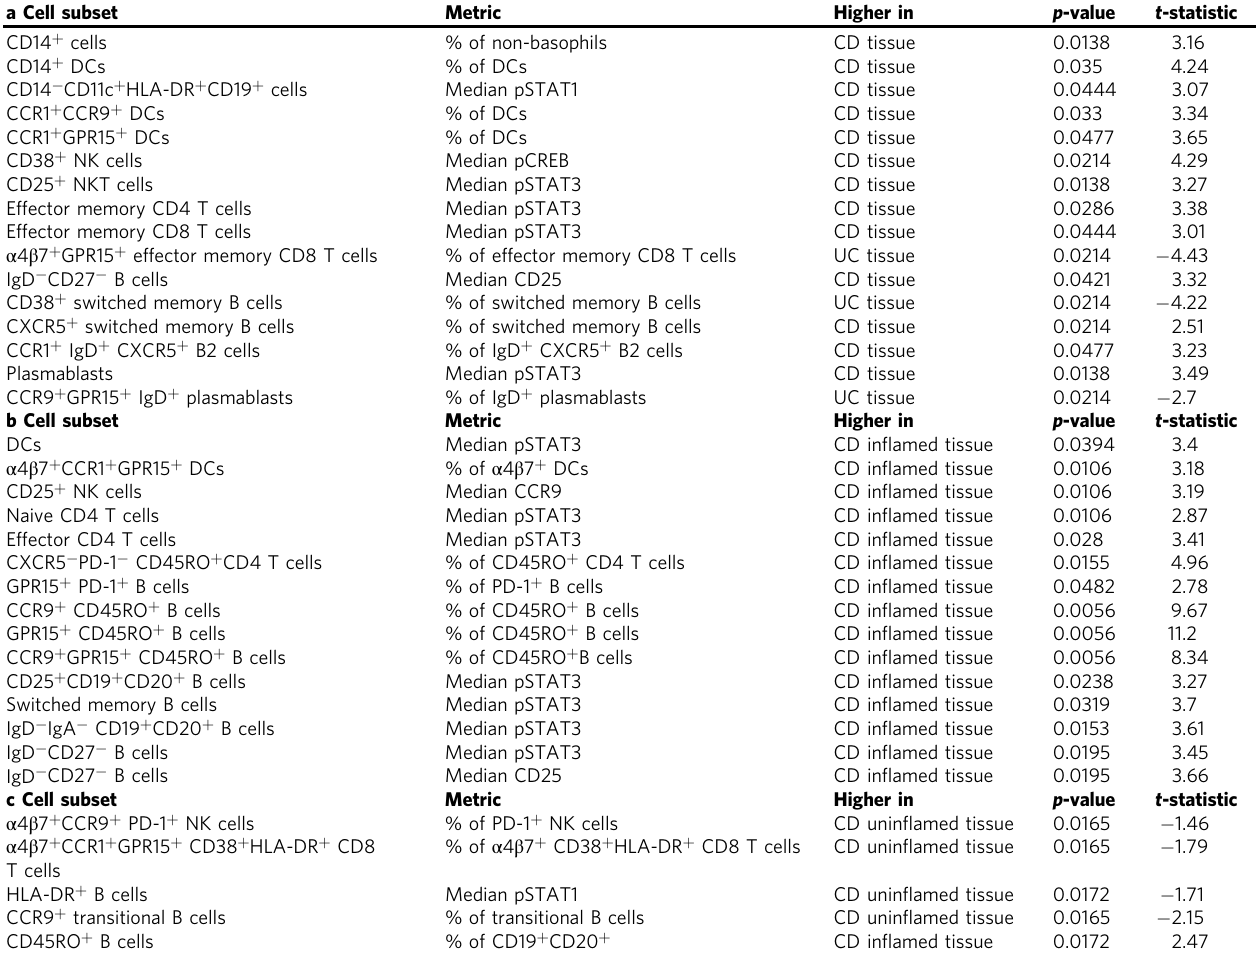
Table 2 Tissue leukocytes that distinguish diseases and in fl ammation states reveal shared signatures a Cell